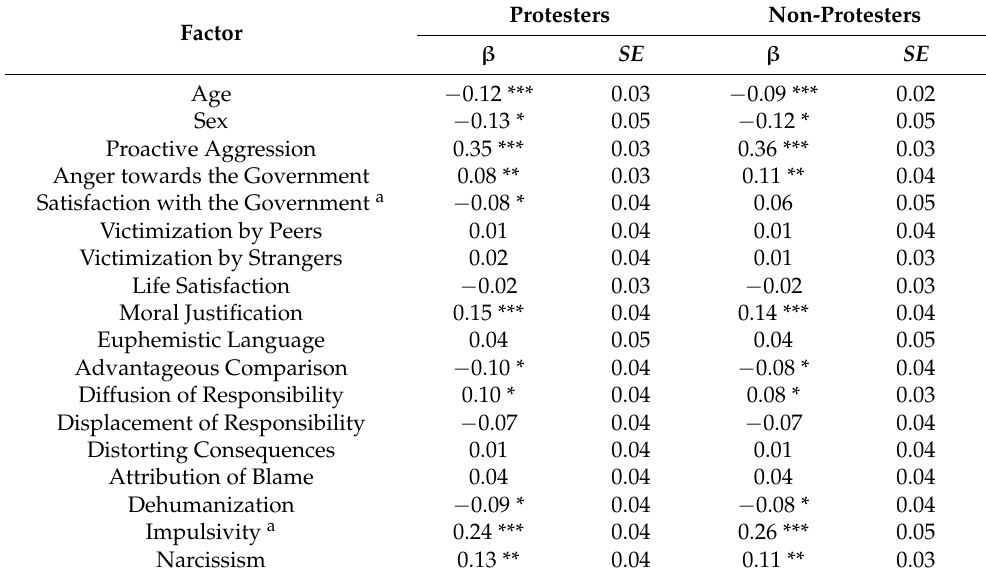
Table 8. Final Multiple Group Model Predicting Reactive Aggression.